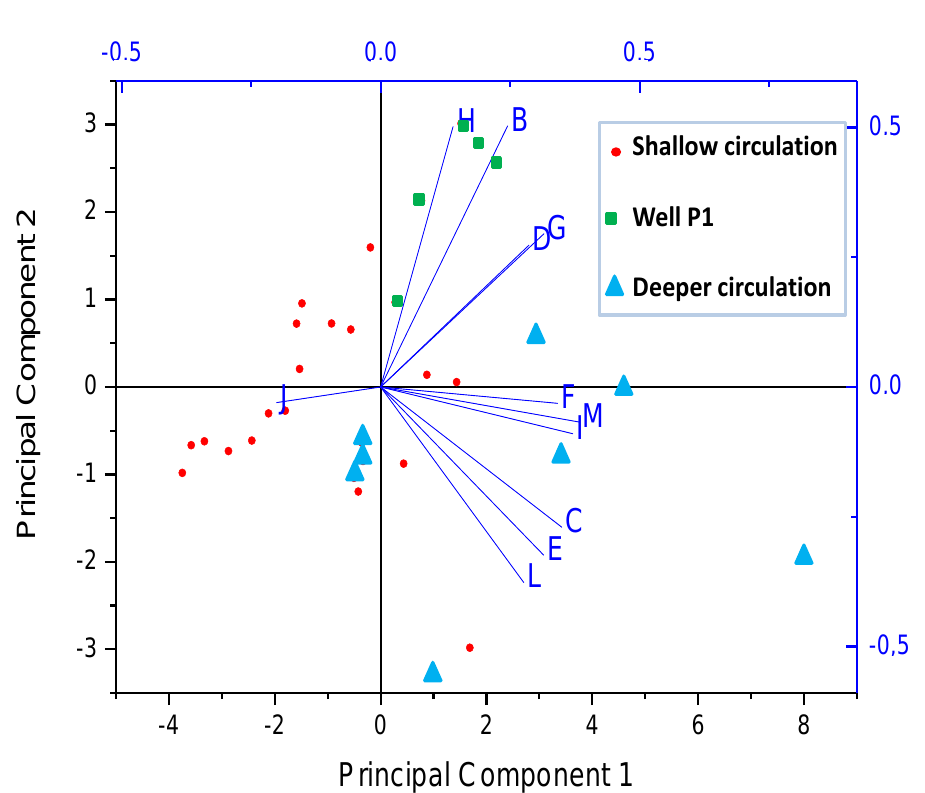
Figure 9. Bi-plot of principal components PC1 and PC2 of physicochemical data of groundwater in the area of Ostia Antica archaeological park. Eleven variables were selected: B. HCO 3 ; C. Cl; D. SO 4 ; E. Ca; F. Mg; G. Na; H. K; I. Br; J. Water table level; L. Br/Cl; M. EC. Shallow circulation is referred to wells P2, P3, P4, P8, P9, and P10; deeper circulation is linked to wells P6 and P7.